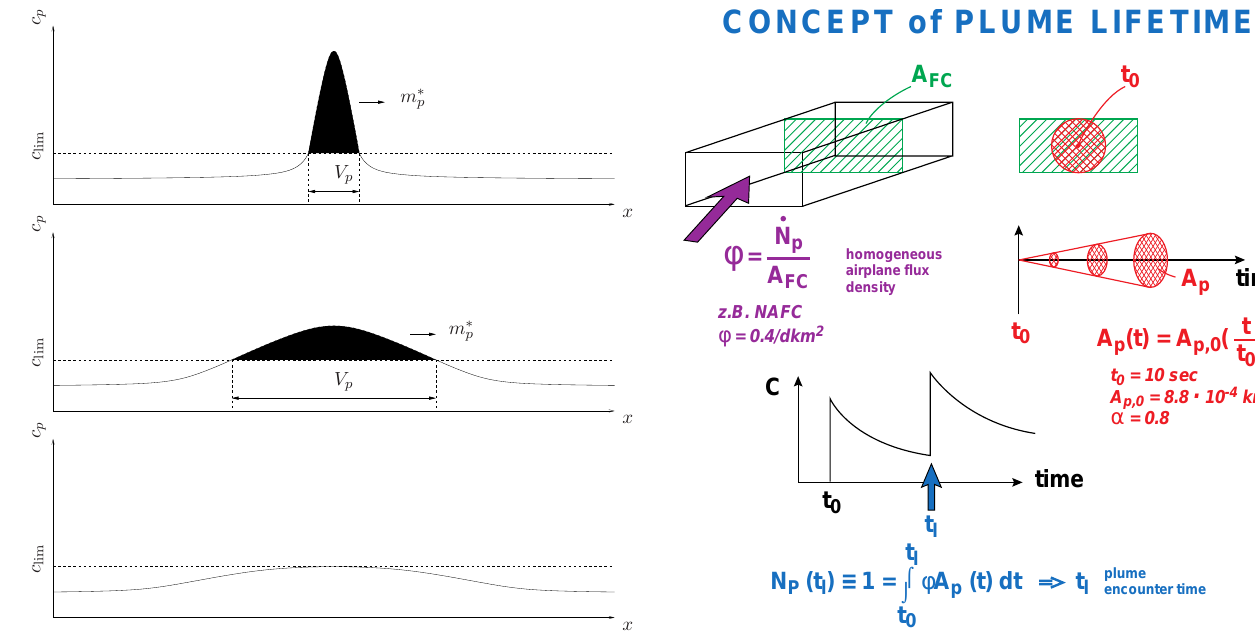
Fig. 6. Concept of plume lifetime used by Cariolle et al. (2009). Evolution of the excess of mass m ∗ p over a threshold concentraion c lim of a chemically conserved species in the plume, from t = t 0 (top panel) to t = t lim (bottom panel). The plume lifetime t p = t lim is defined as the time when m ∗ p = 0.